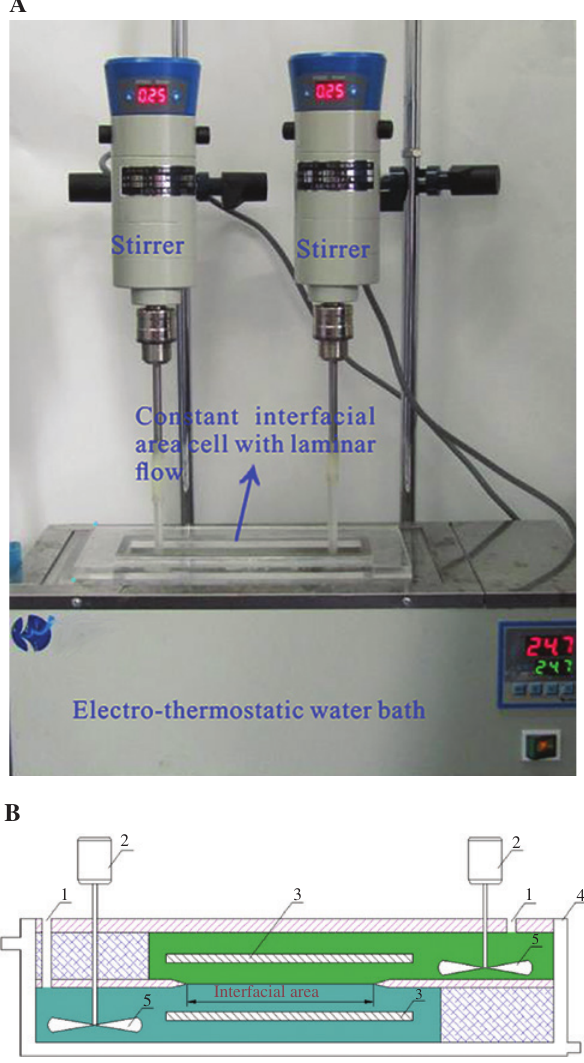
Figure 1: Experimental devices of kinetics (A) and the structure of constant interfacial area cell with laminar flow